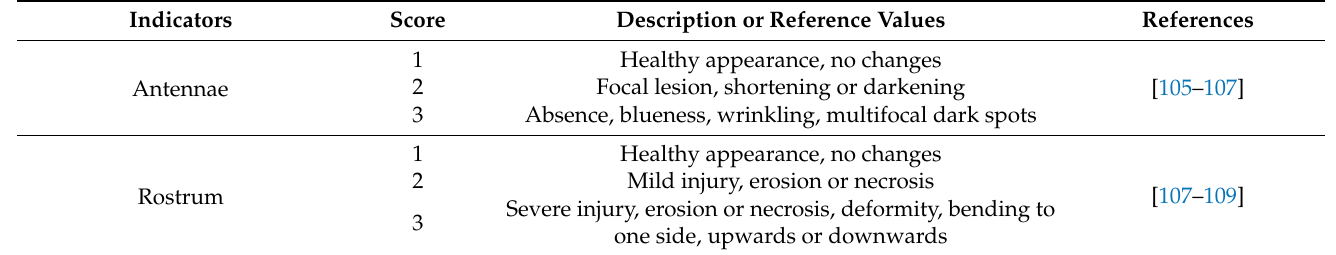
Table 3. Health indicators for Penaeus vannamei